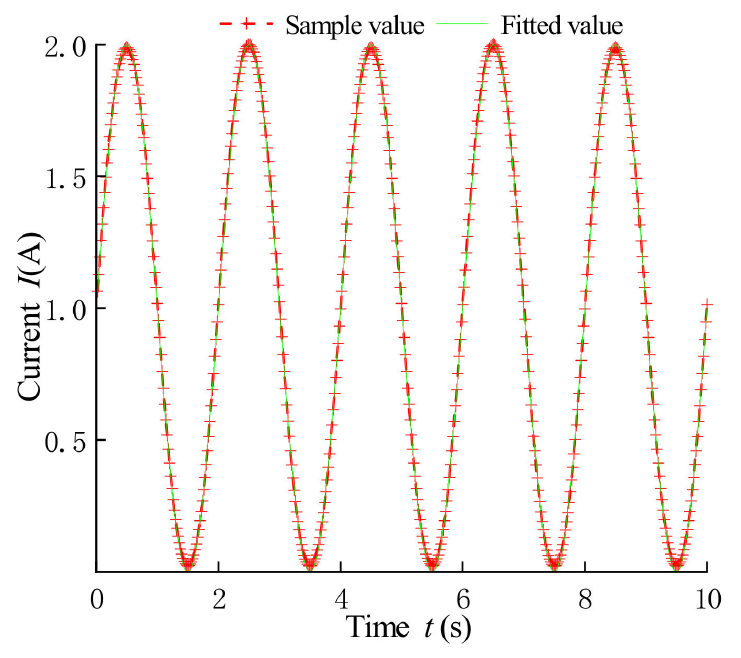
Figure 13. Fitting accuracy curve using BP neural